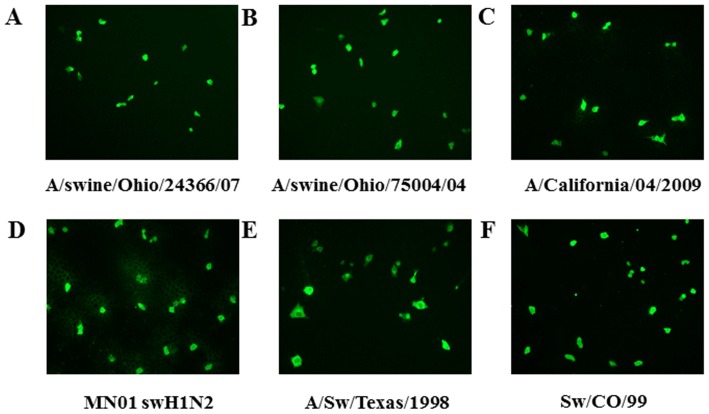
Immunofluorescence pictures of different IAV strains.MDCK cells were infected with indicated IAV strains at an approximate MOI of 0.01. The inoculum of each IAV strain was adjusted to obtain approximately 50–150 fluorescent focal units (FFU) per well following infection for 20 hr. Each FFU is from a single or multiple IAV infected cells in a single fluorescent area.